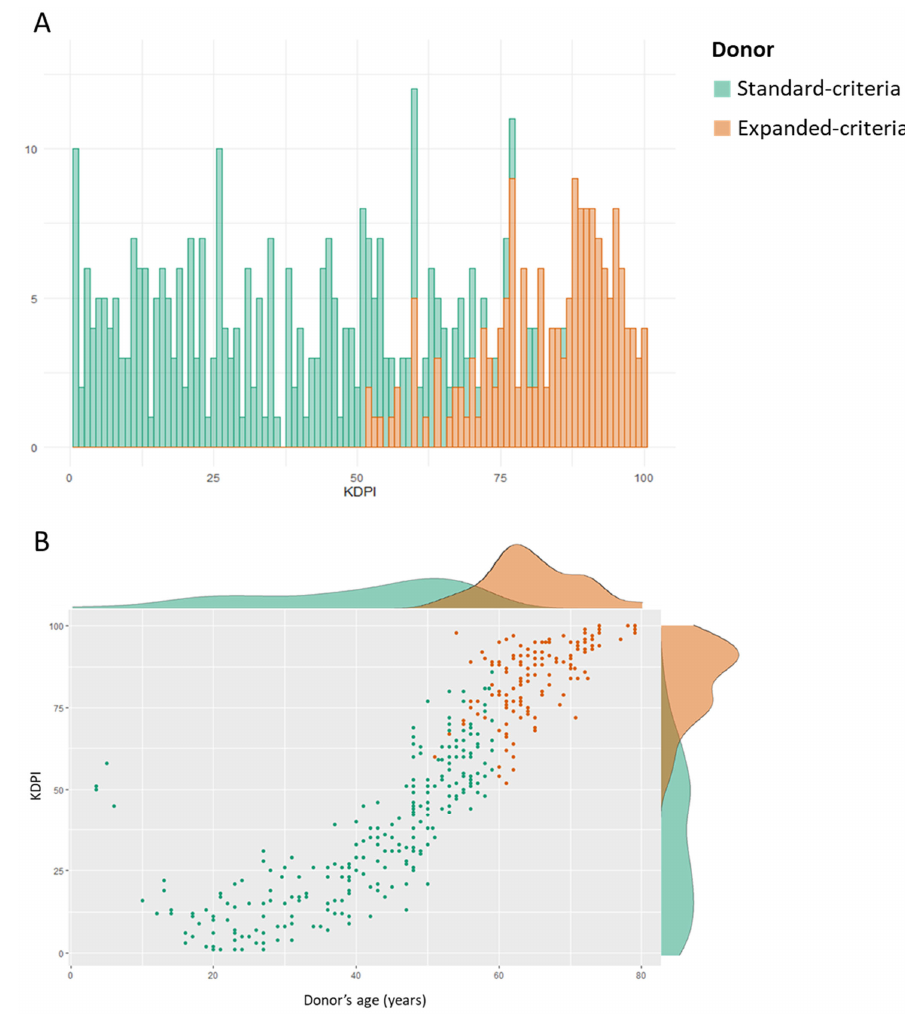
Figure 1. Distribution of KDPI among standard-criteria and expanded-criteria donors ( A ). Scatterplot showing the relationship between donor age and KDPI. Donor age was significantly correlated to higher KDPI (Spearman ρ : 0.924, p -value < 0.001) ( B ).